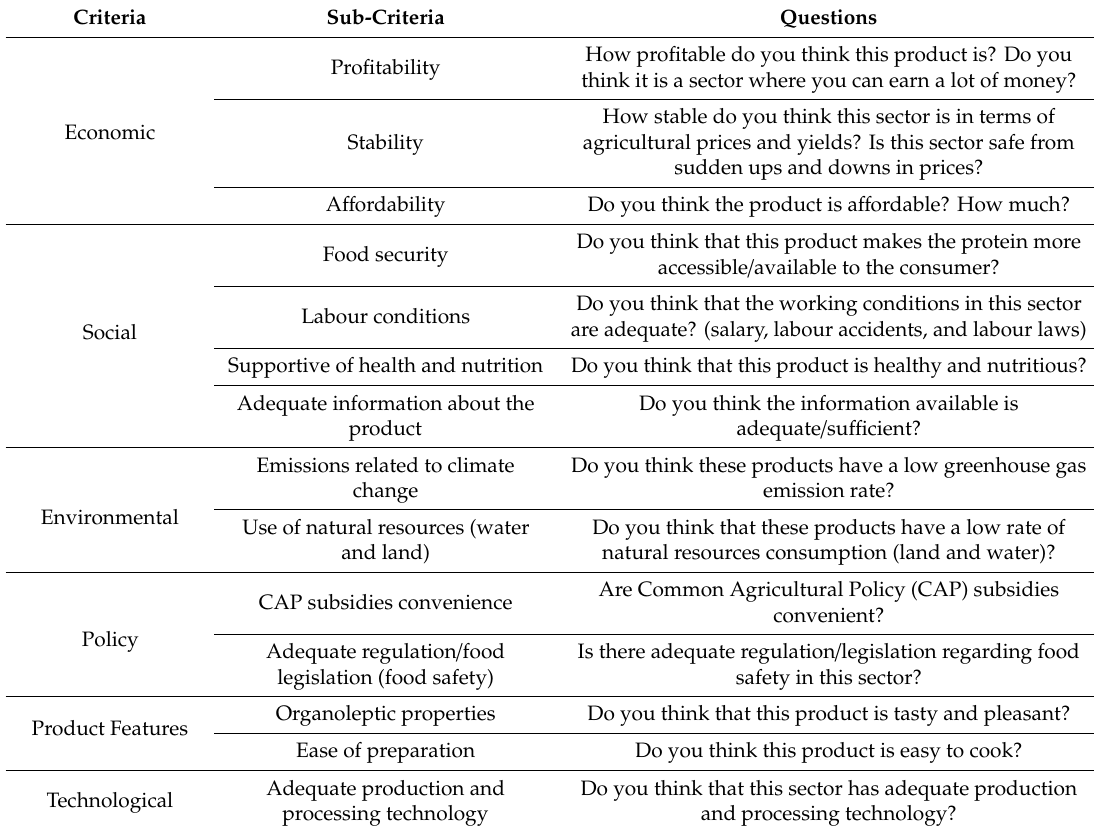
Table 1. Criteria, sub-criteria, and questions included in the